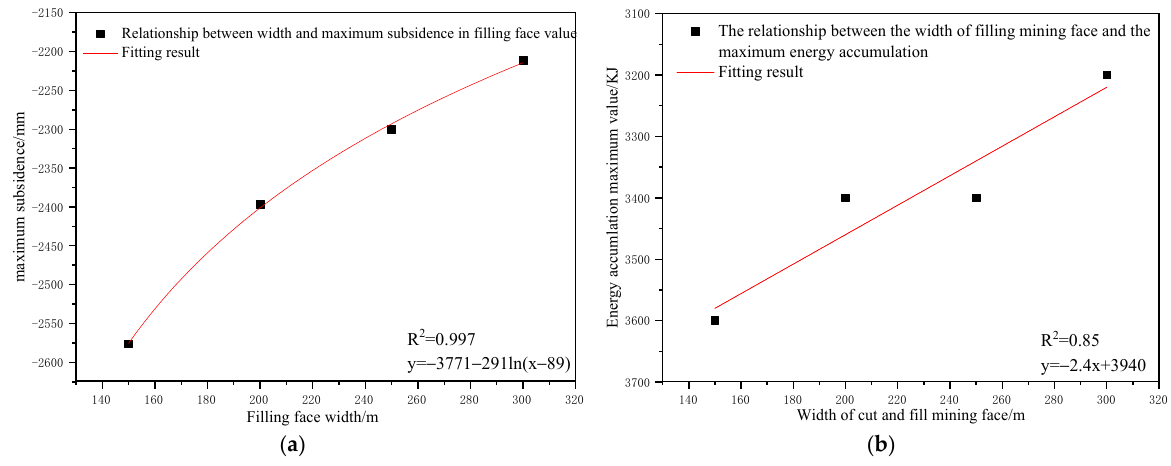
Figure 12. Influence of filling face scale on the control effect of partial filling mining based on the main key stratum; ( a ) relationship between filling face scale and maximum surface subsidence. ( b ) Relationship between filling face scale and energy accumulation maximum value.